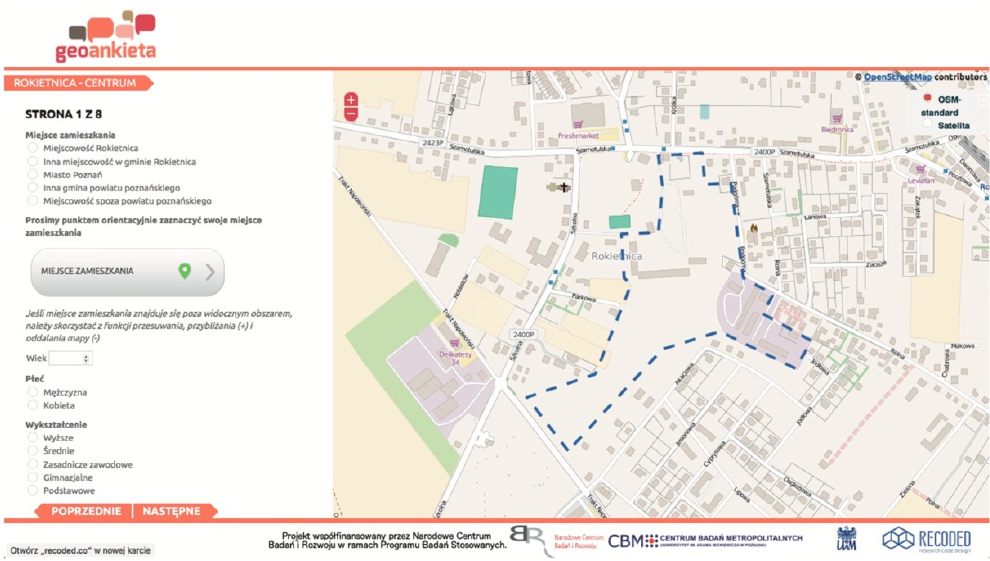
Figure 3. An exemplary page of the geo-questionnaire.